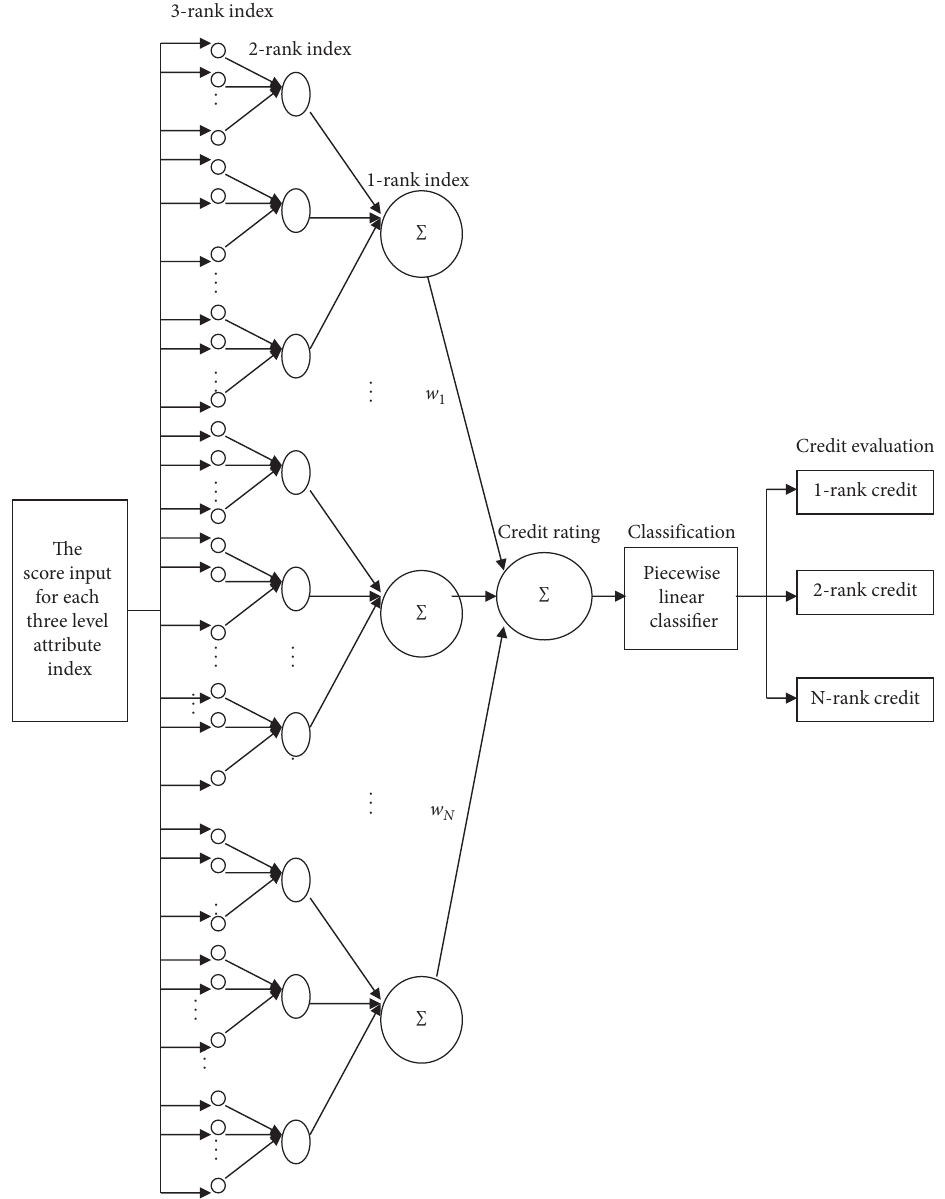
Figure 1: Farmer’s credit rating system based on four-layer unidirectional